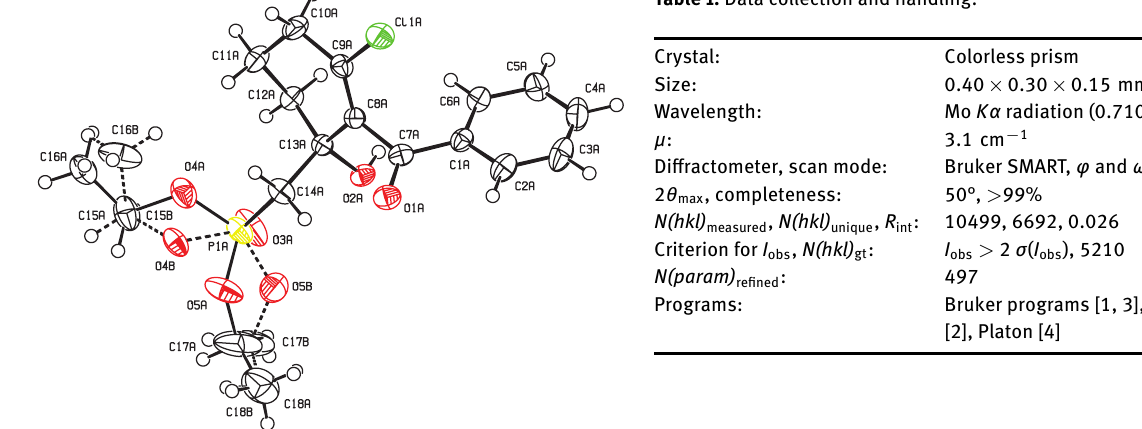
Table 1: Data collection and